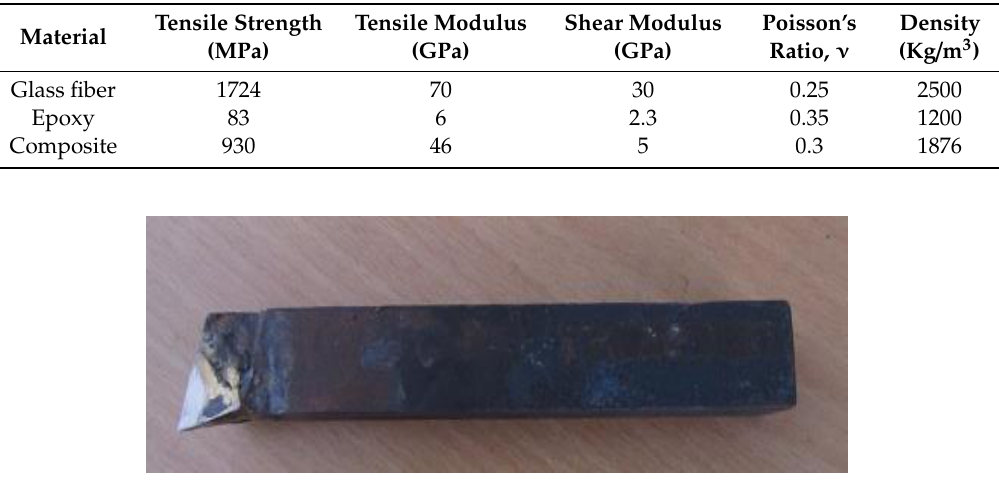
Figure 2. GFRP Specimen. Table 1. Mechanical properties of Epoxy, Glass fiber and Composite material [21].